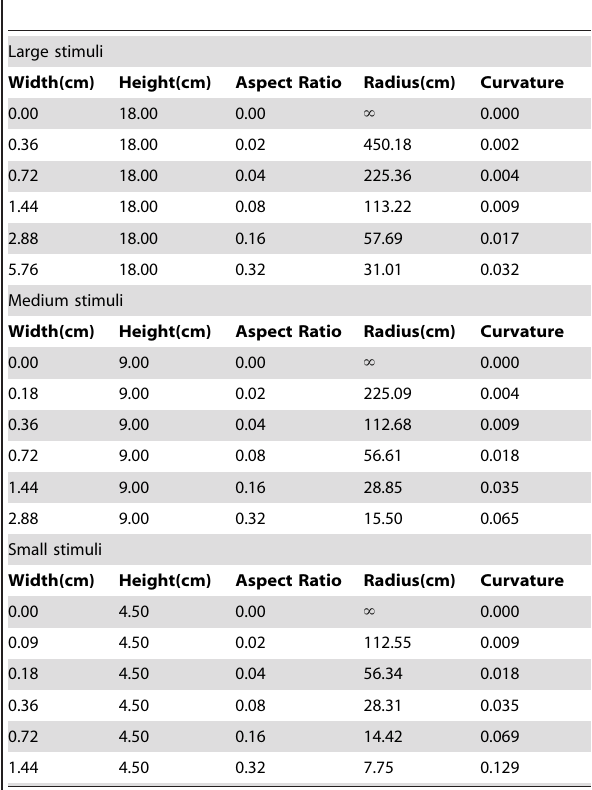
Table 1. Parameters of stimuli used in the size constancy